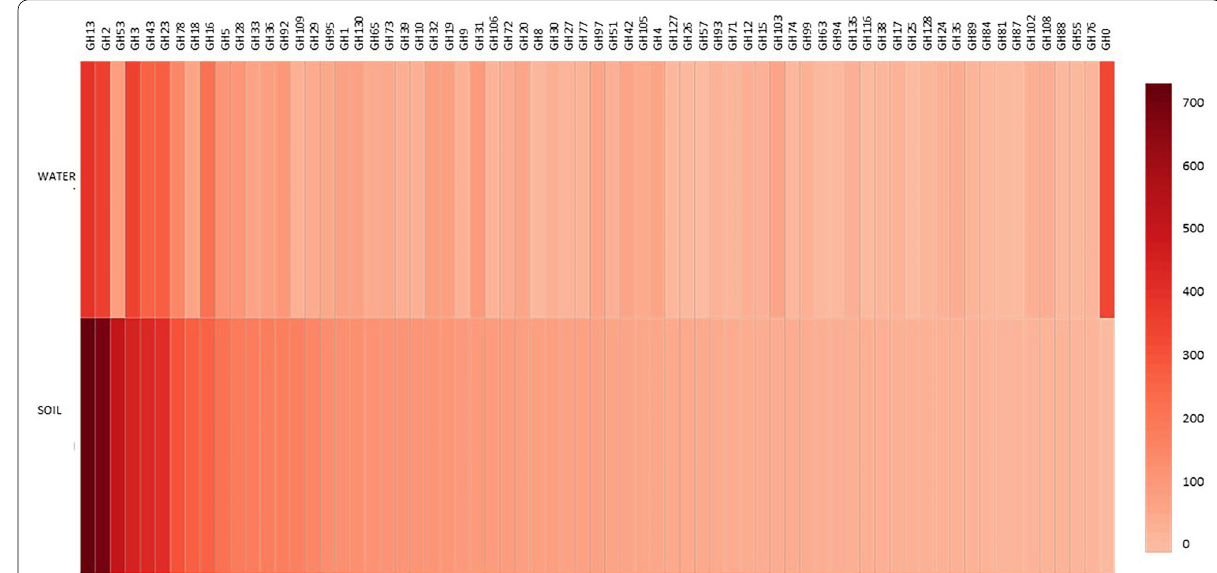
Fig. 3 The heat map depicts the presence of glycoside hydrolases in ABS1 and ABSLW